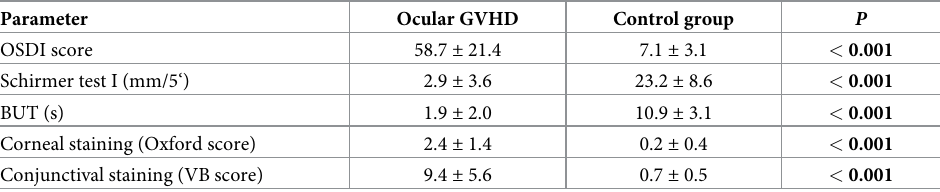
Table 2. Ocular surface parameters in patients with ocular GVHD and control subjects.